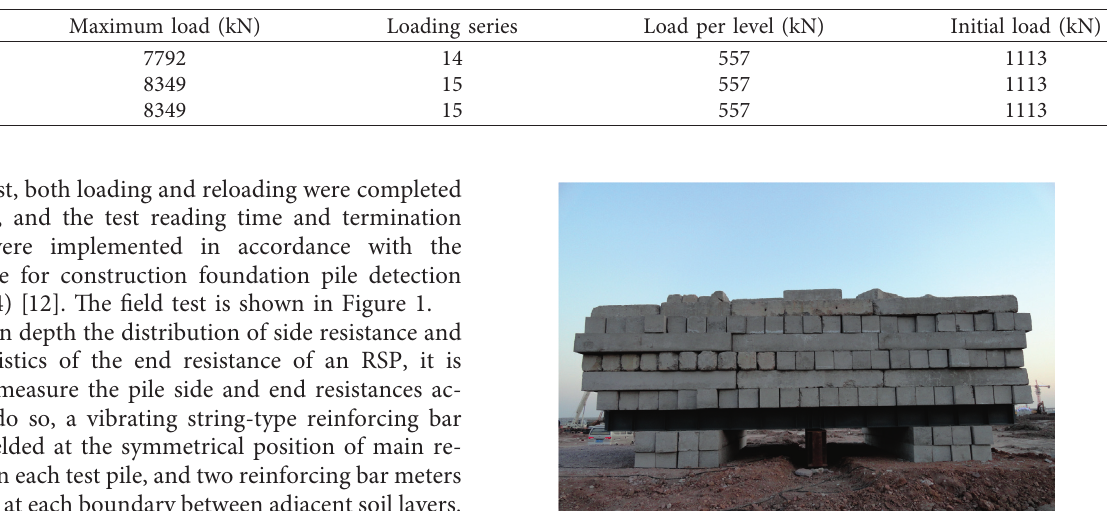
Table 3: Loading parameters of the static load test.